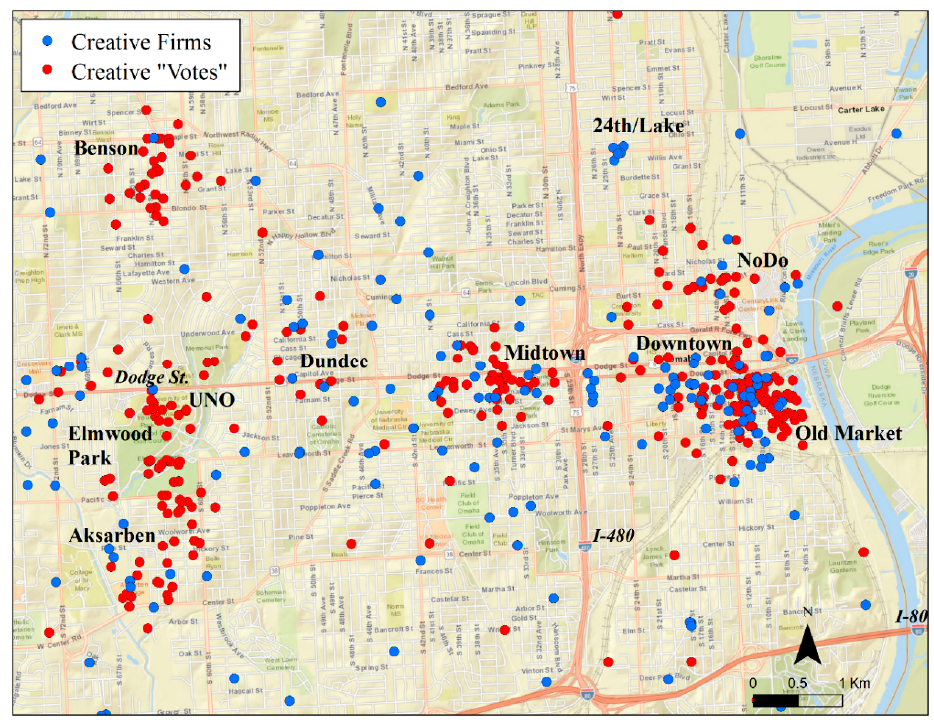
Figure 3. The location of creative firms and creative “votes” within Omaha’s “central corridor.” Basemap courtesy of Esri™ [73].